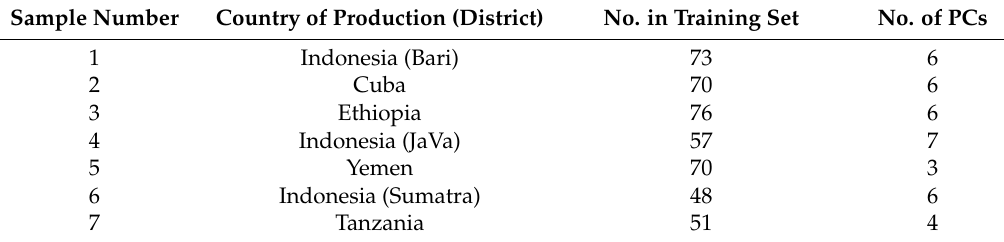
Table 2. Number or training set and principal components (PCs) for each measurement sample.